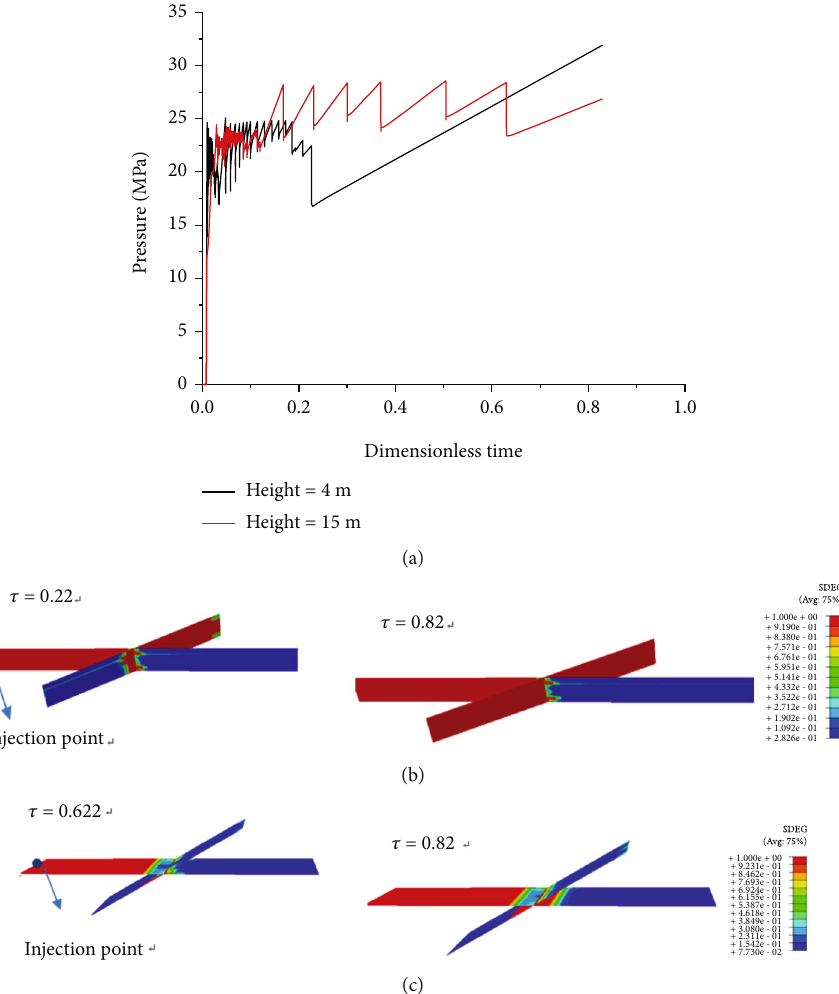
Figure 8: The numerical result comparison between 4m and 15m formation thickness with a 30-degree approaching angle: (a) the fl uid pressure history at the injection point; (b) damage factor (SDEG) contours with a 4m formation thickness (deformation scale factor = 100 ); and (c) damage factor (SDEG) contours with a 15 m formation thickness. The SDEG in the legend means the damage factor of cohesive